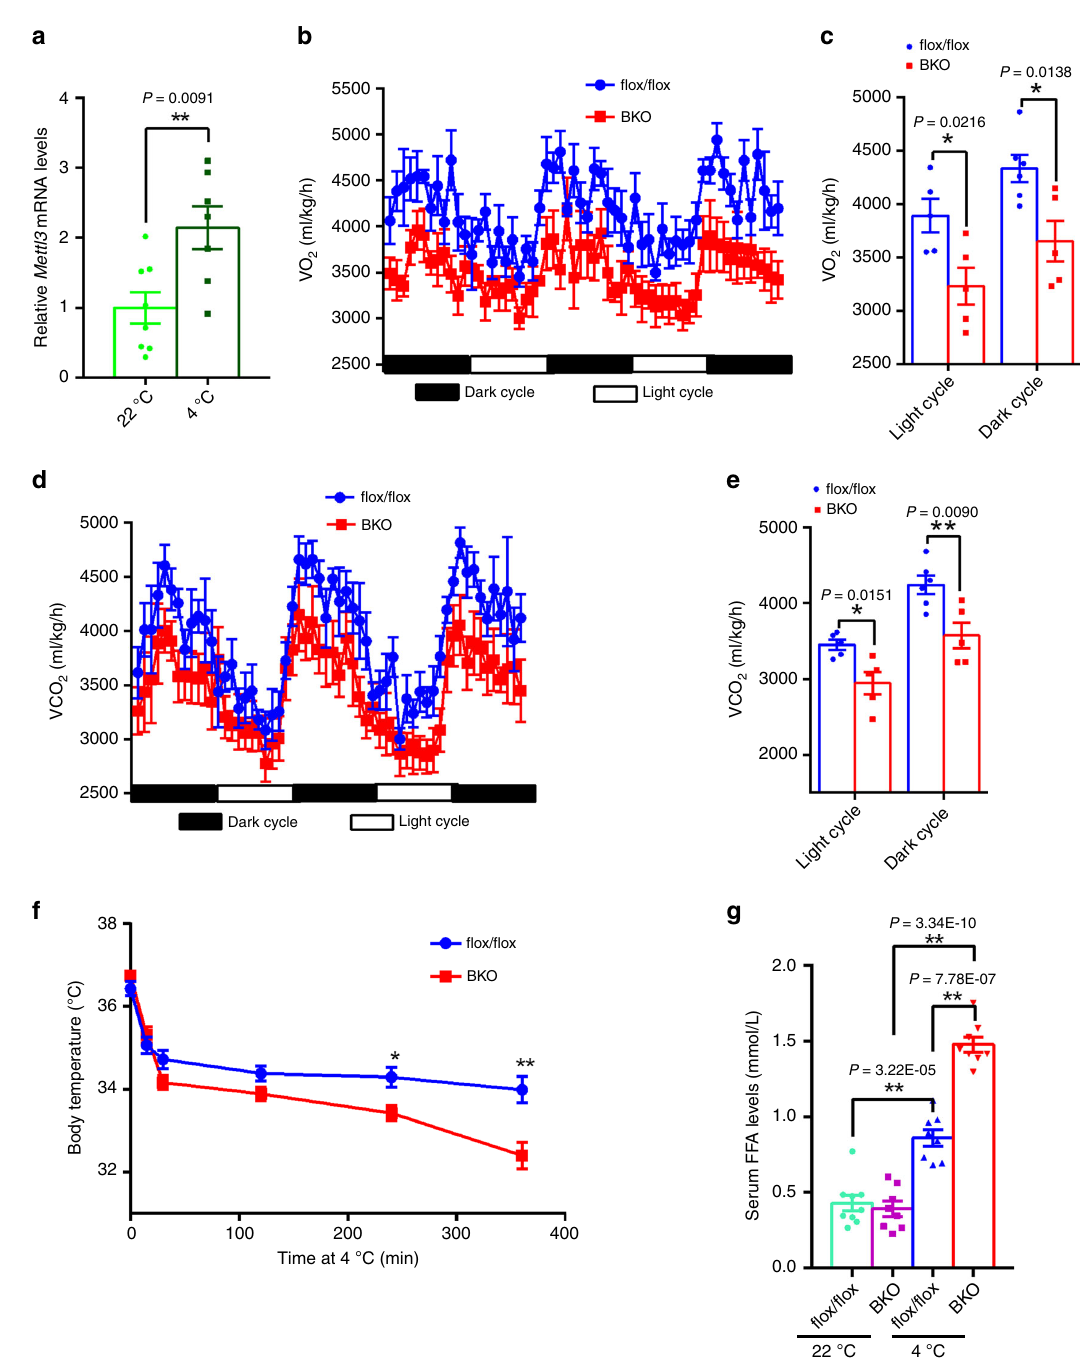
Fig. 7 Mettl3 de fi ciency in BAT decreases energy expenditure and impairs cold tolerance. a The Mettl3 mRNA levels in iBATs of WT mice after acute cold exposure for 6h (22°C, n = 8; 4°C; n = 7). b , c The O 2 consumption rates in 8-week-old Mettl3 fl ox/ fl ox and BKO mice at 22°C ( n = 5 – 6 for each group). d , e The CO 2 production rates in 8-week-old Mettl3 fl ox/ fl ox and BKO mice at 22°C ( n = 5 – 6 for each group). f The rectal temperature of 8-week-old Mettl3 fl ox/ fl ox and BKO mice during acute cold exposure (4°C) ( Mettl3 fl ox/ fl ox , n = 10; BKO, n = 9). g Serum FFAs levels of 8-week-old Mettl3 fl ox/ fl ox and BKO mice housed at room temperature or after cold exposure (4°C) for 6h (22°C Mettl3 fl ox/ fl ox , n = 9; 22°C BKO, n = 8; 4°C Mettl3 fl ox/ fl ox , n = 8; 4°C BKO, n = 8). Data represent the mean±SEM. Signi fi cance was determined by unpaired two-tailed Student ’ s t test analysis. * p <0.05. ** p <0.01. Source data are provided as a Source Data fi